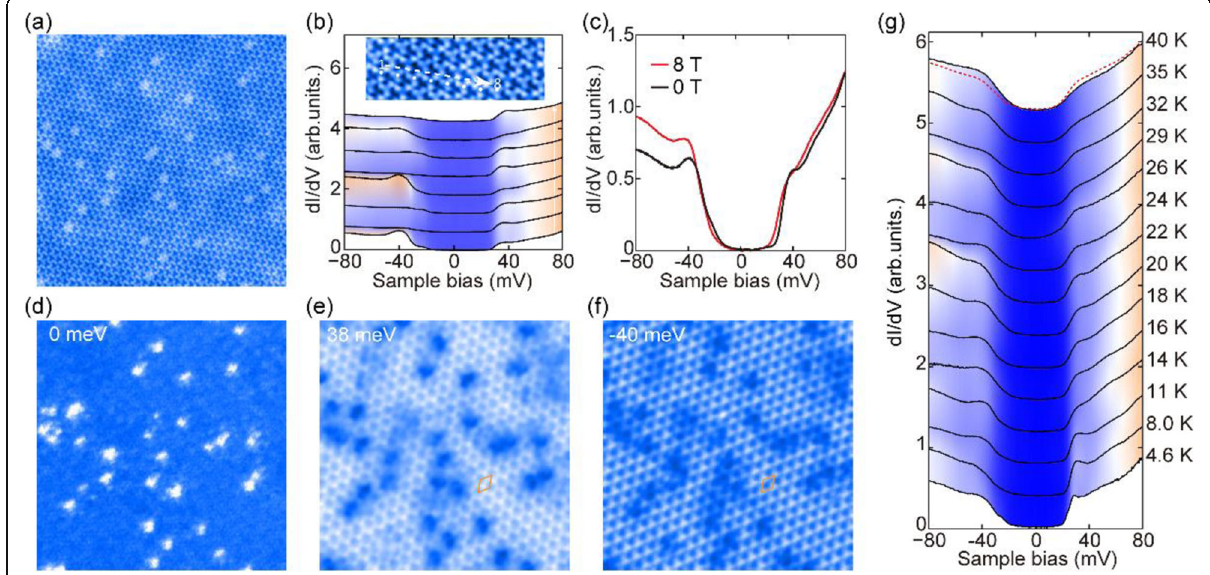
Fig. 13 Absence of superconductivity in bilayer K 3 C 60 ( a ) STM topography of bilayer K 3 C 60 , interspersed with small amount of excess K dopants. ( b ) d I /d V spectra along the white dashed line in the inset. ( c ) Averaged d I /d V spectra at B = 0 and B = 8 T. ( d - f ) Electronic DOS maps with an energy of ( d ) 2 meV, ( e ) 38 meV, and ( f ) − 40 meV, acquired simultaneously in the same field with ( a ) at B = 8 T. ( g ) Spatially averaged d I /d V spectra as a function of temperature. The red dashed line shows the convolution of electronic DOS measured at 4.6 K with a Fermi-Dirac function with T = 40 K. Taken from ref.